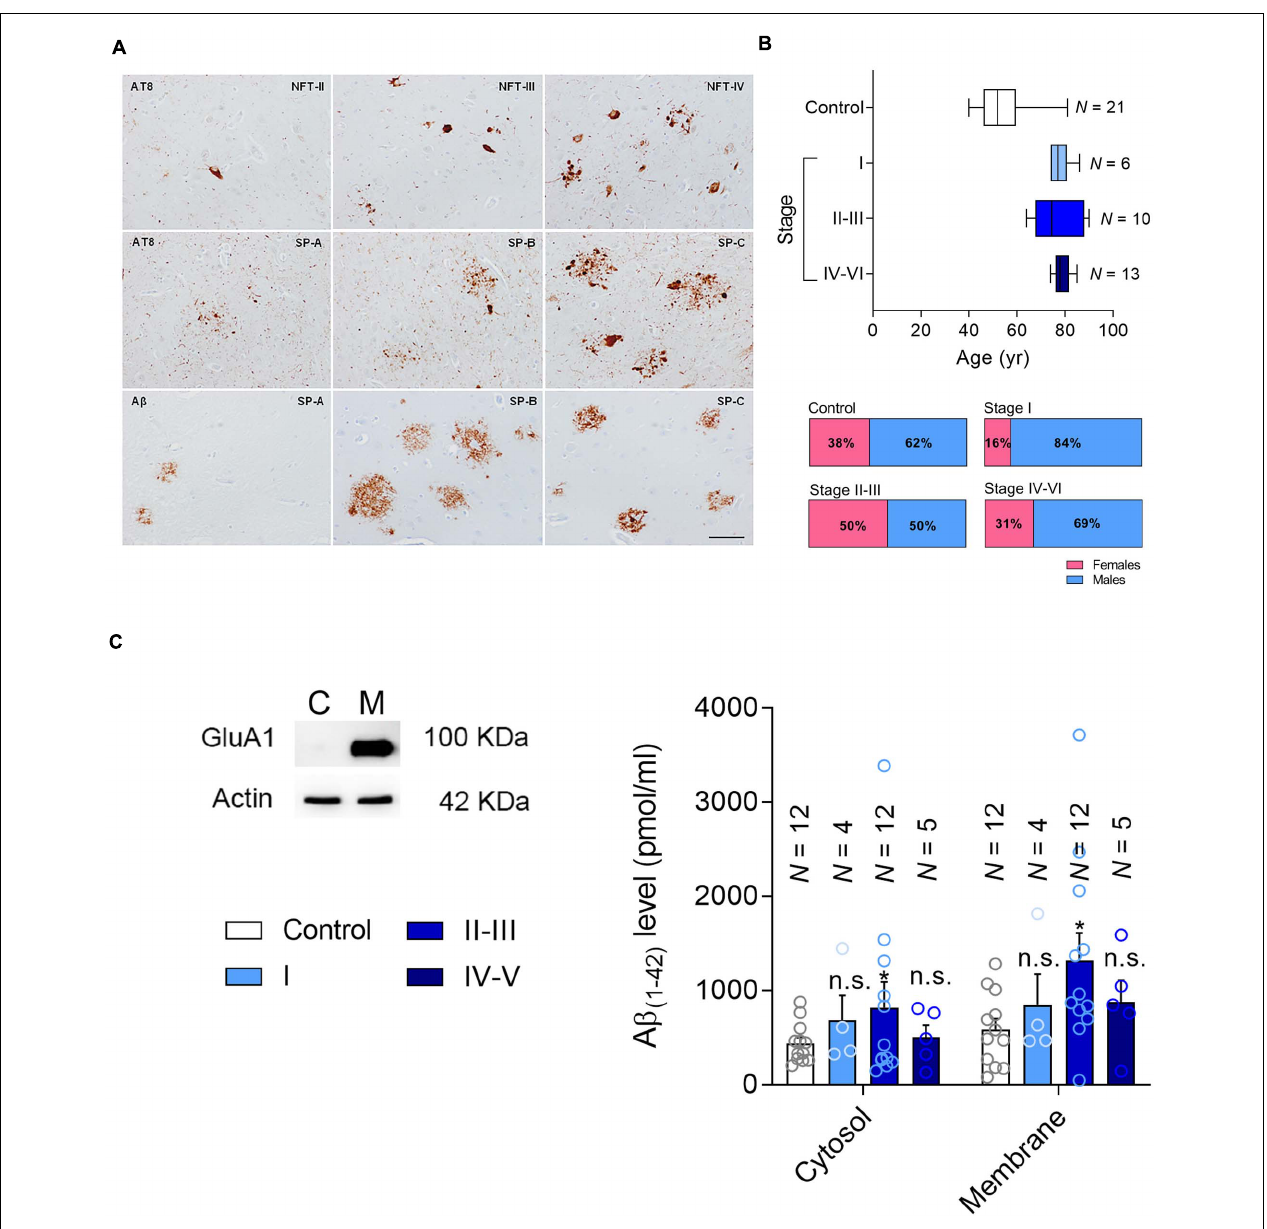
FIGURE 1 | Patient classification and A β measurement. (A) Representative changes in pathological Alzheimer’s disease revealed with anti-phosphorylated tau (clone AT8) and A β antibodies, categorized following the Braak and Braak nomenclature adapted for immunohistochemistry in paraffin sections: NFT II, III and IV indicate neurofibrillary tangle pathology stages II, III and IV; SP A, B and C refer to senile plaque burden stages A, B and C. The upper row mainly focuses on the NFT pathology, whereas the middle row on the tau pathology surrounding amyloid deposits. The lower row shows the morphology of diffuse plaques on the left and the core plaques on the right, with a mixture of them in the central image. (B) The age range (Top) and gender of the patients in the current cohort (Bottom). (C) Left, the hippocampal formation was fractionated into the cytosolic (C) and membrane fractions (M), testing the efficacy of this separation in western blots probed for the AMPAR subunit as a marker of the membrane fraction marker. Right, A β levels were determined by ELISA [pg/ µ g protein] in the cytosolic and membrane fractions. N is the number of patients, and the data are presented as the average ±